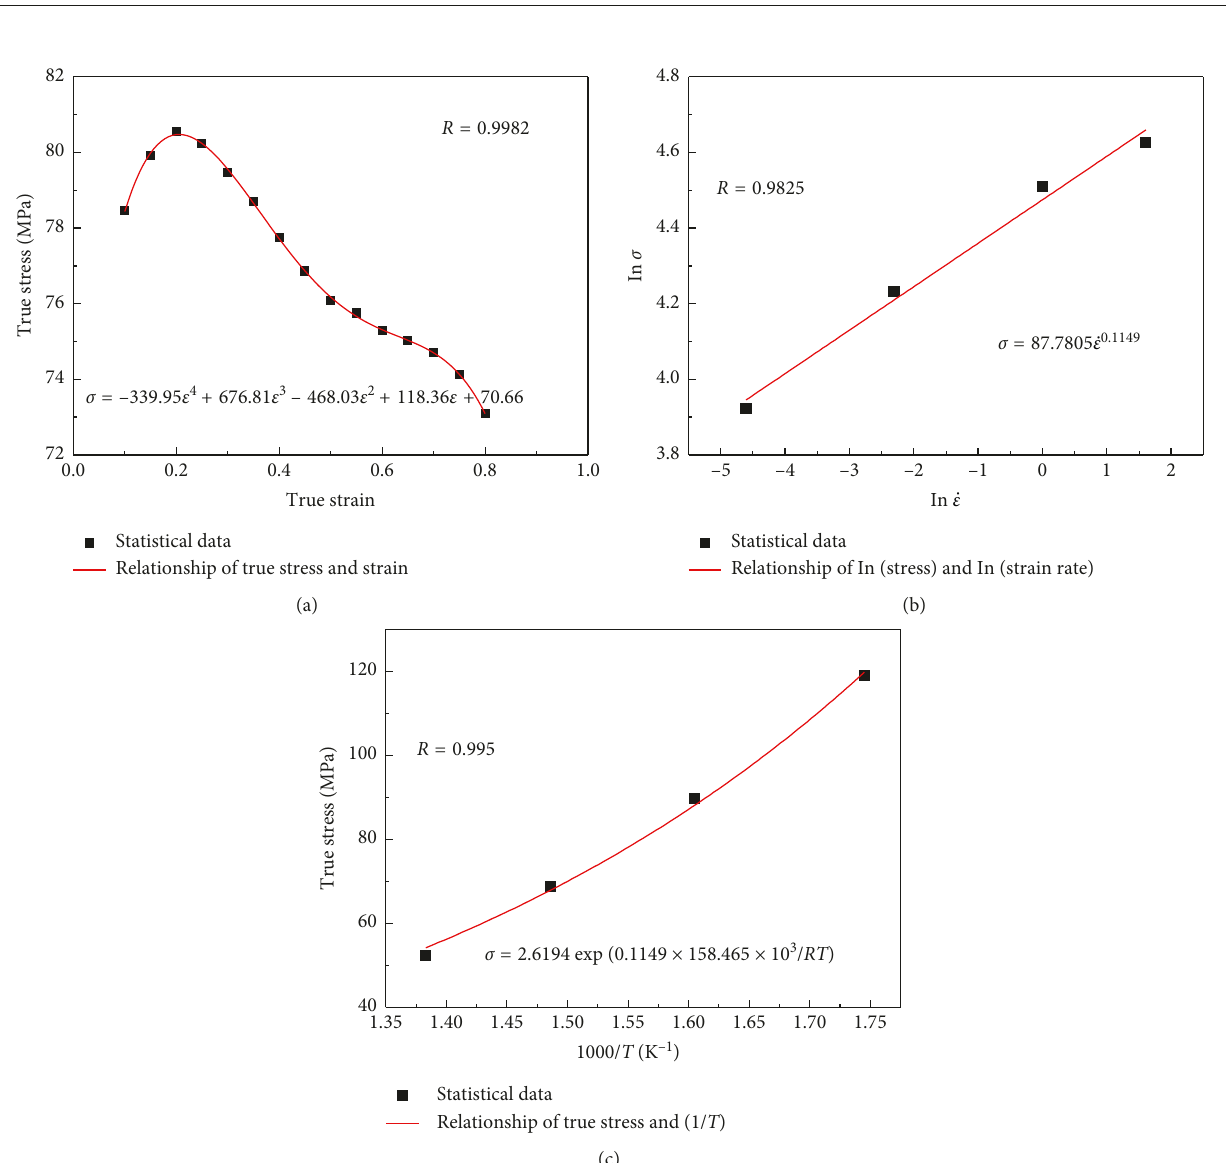
Figure 4: Correlation between(a)truestressandstrain;(b)ln(truestress)andln(strainrate);and(c)truestressand1000/ T